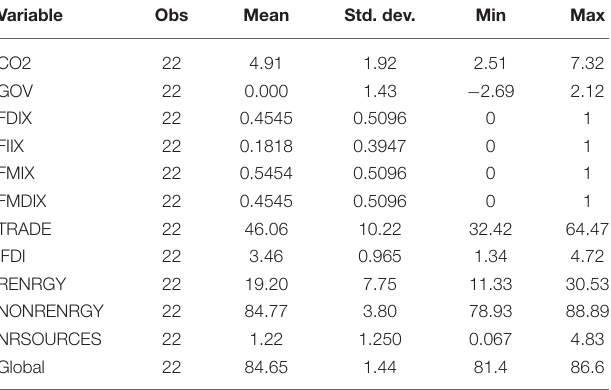
TABLE 2 | Summary